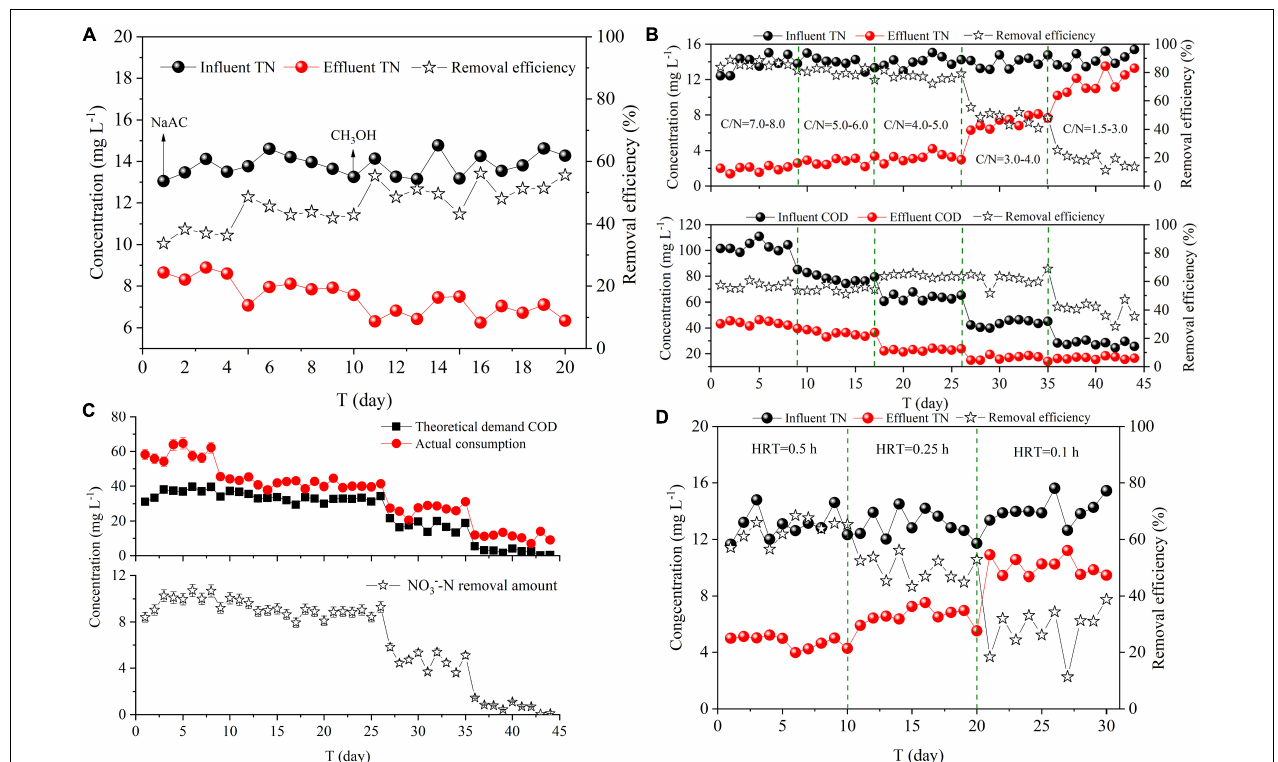
FIGURE 2 | Effect of operating conditions on TN removal (A) Carbon source types, (B,C) C/N ratios, (D) HRT.